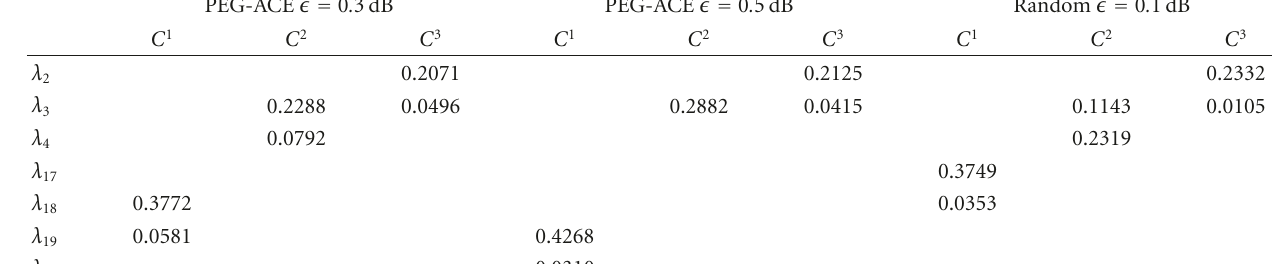
Table 1: Variable node degree distributions for two PEG-ACE codes ( (cid:2) = 0 . 3dB and (cid:2) = 0 . 5 dB) and the random (cid:2) = 0 . 1 dB code.